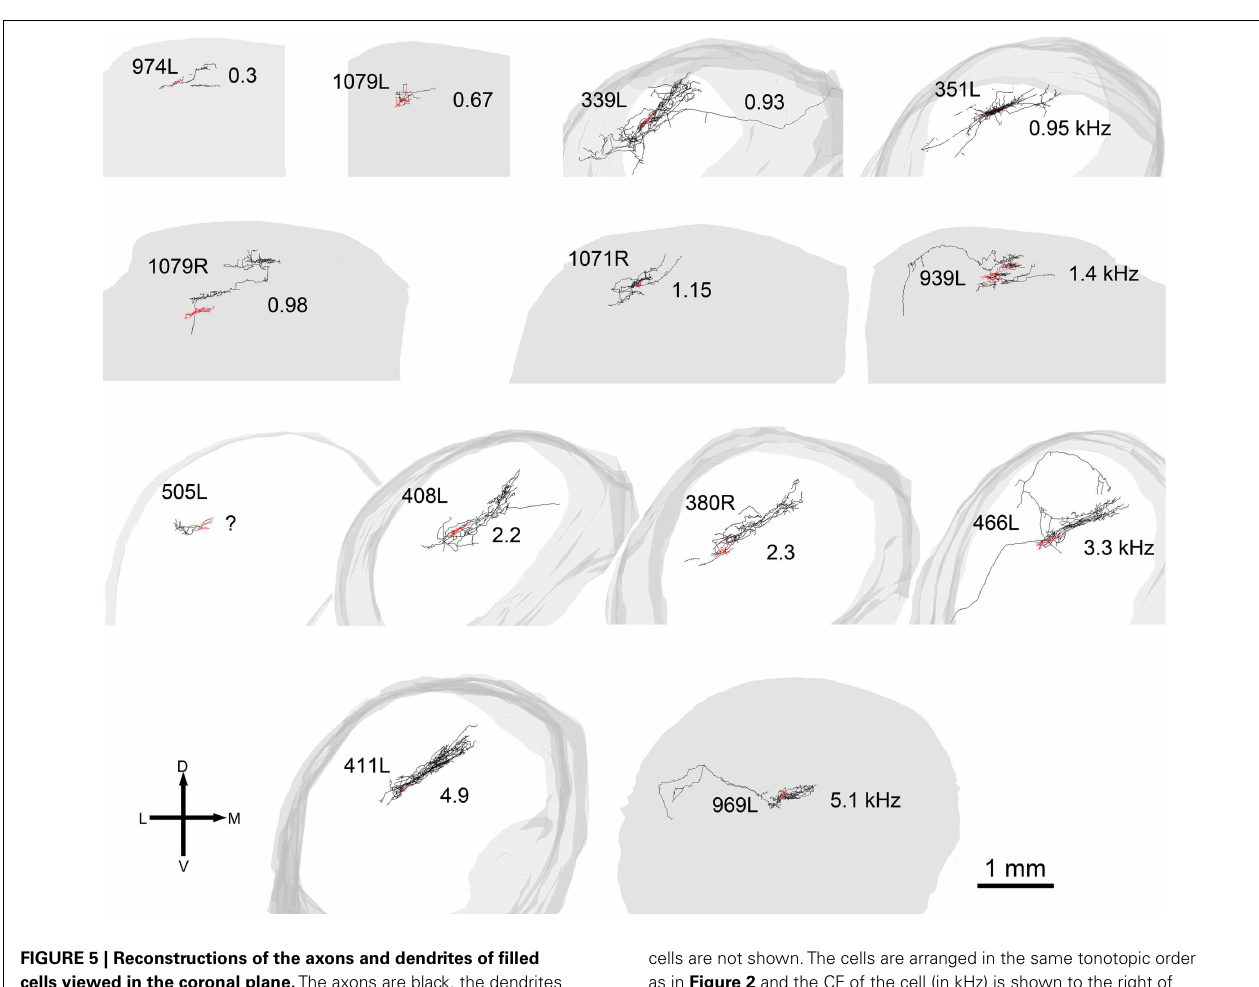
FIGURE 5 | Reconstructions of the axons and dendrites of filled cells viewed in the coronal plane. The axons are black, the dendrites are red, and the shape of the IC is represented in gray. In some cells the axon has been incompletely filled and sections are missing (e.g., 974L) while for two of the cells the axon was not stained and these